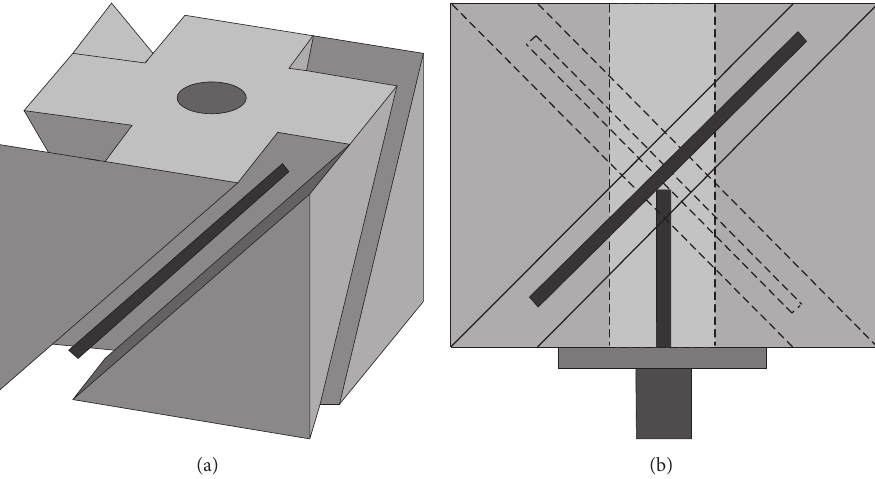
Figure 48: DRA working in circular polarization. The slits on the DR excite the circular polarization, while the metal strips (drawn in black) are used to increase the operating bandwidth of the axial ratio triggering a circular polarization that goes to overlap to that radiated by the DR [195]. Tridimensional view (a) and front view (b).